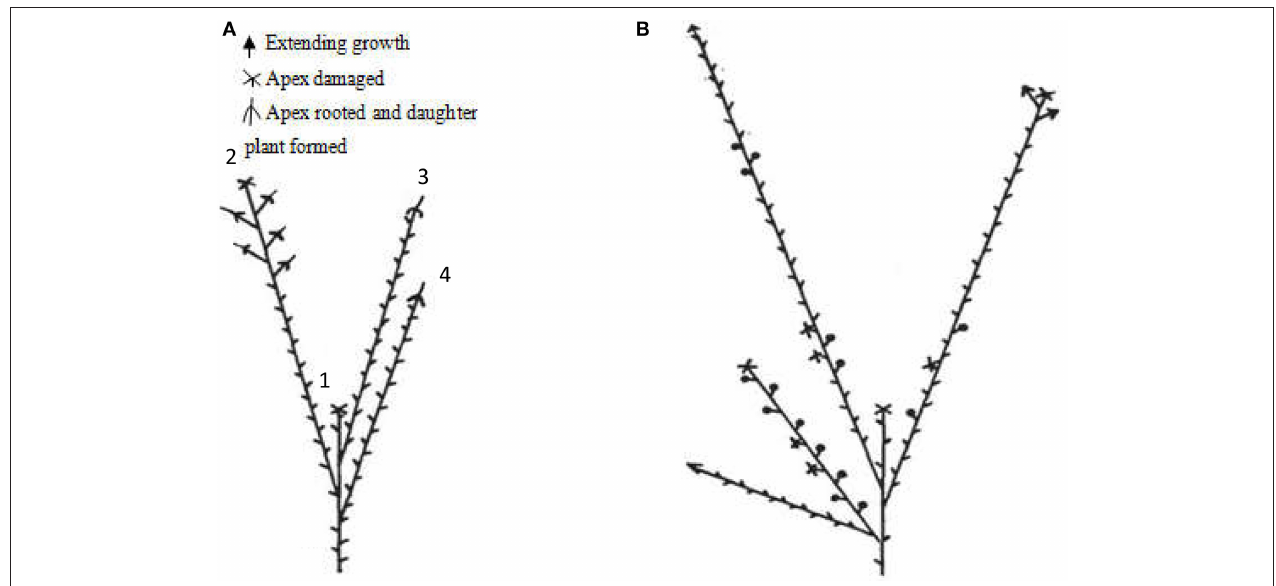
FIGURE 1 | Diagrams of typical late season stems of “Sijihong” red raspberry (modified from Heslop-Harrison, 1959). The state of the buds is as indicated in the key. (A) Characteristics of primocane after terminal bud was removed (stem of the current season’s growth). Shoot 2, 3, and 4 are newly induced lateral branches after the